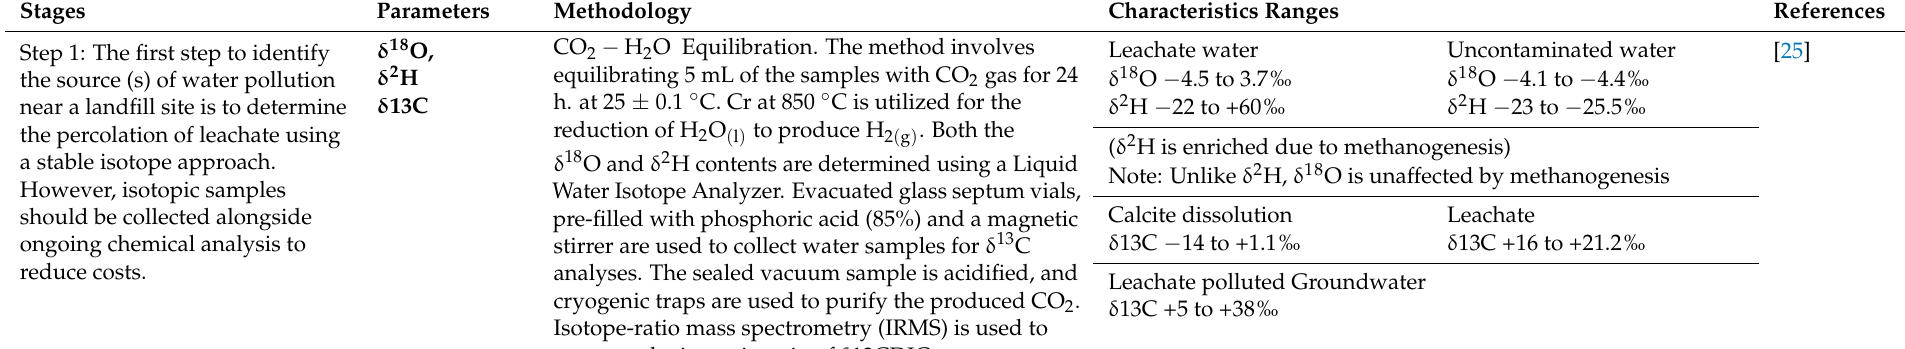
Table 5. Quick guide to pollution source